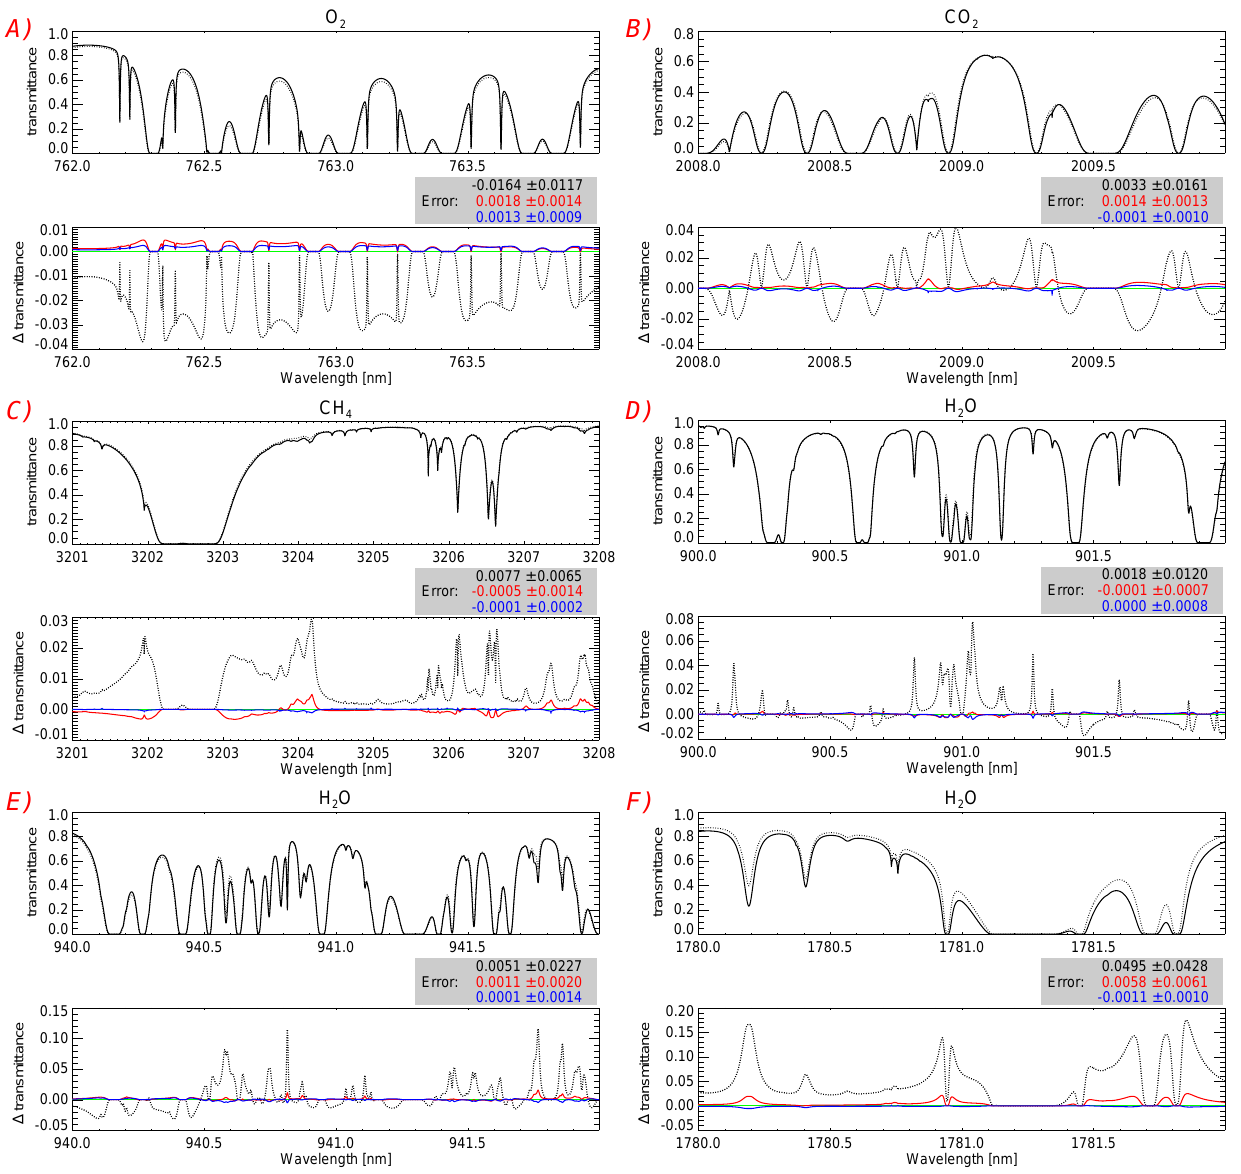
Fig. 9. Same as for Fig. 8, but applying the PCA in optical depth space and calculcating the transmittance afterwards.